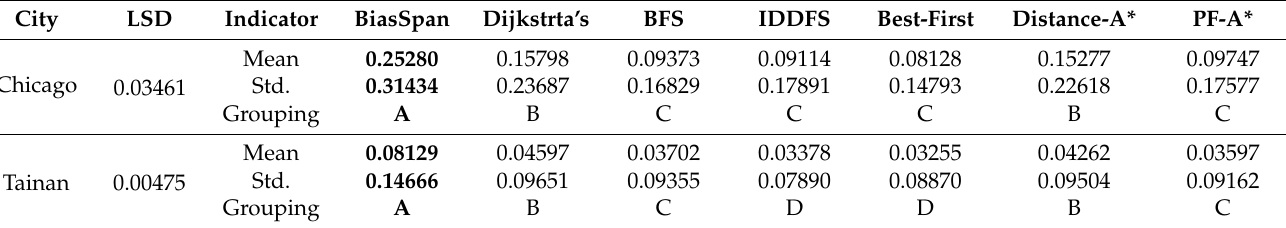
Table 10. Fisher’s LSD test based on one-way